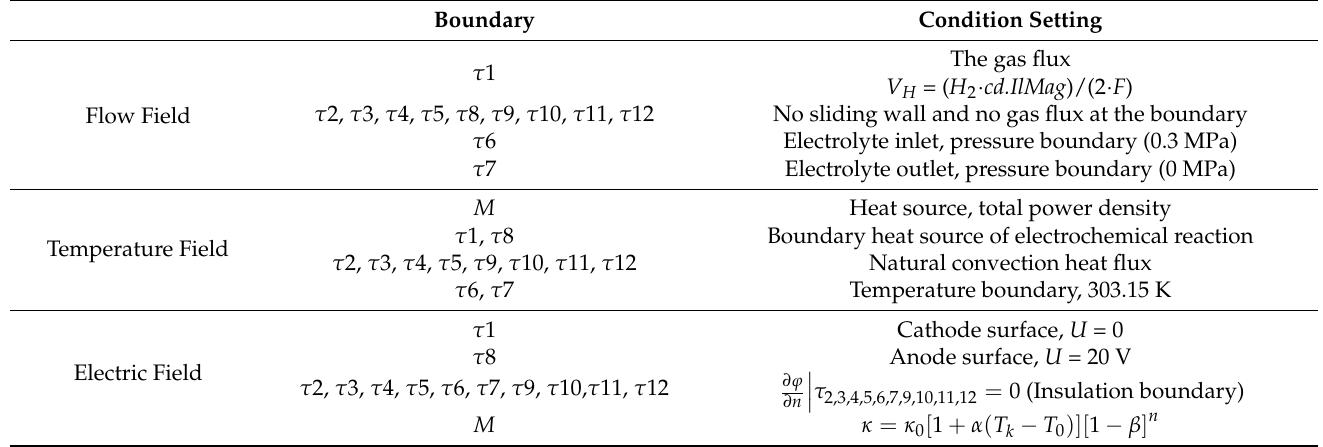
Table 2. Boundary conditions setting of multiple physical fields.